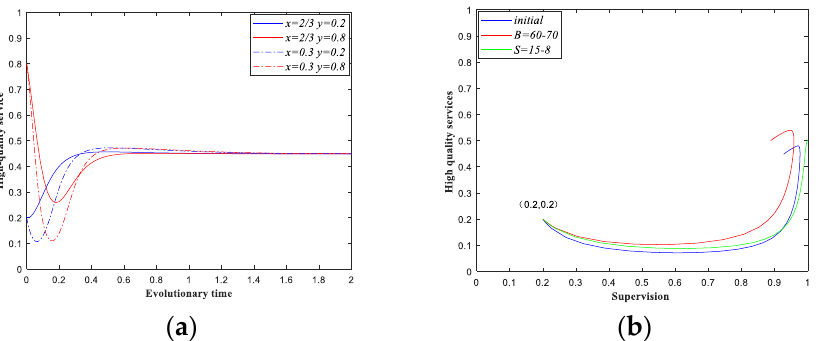
Figure 6. Evolutionary paths of Scenario 4 under dynamic subsidy strategy. ( a ) Evolutionary paths of the private sectors when the proportion of supervision is fixed. ( b ) Evolutionary paths of the two types of participants under the variation of parameters.